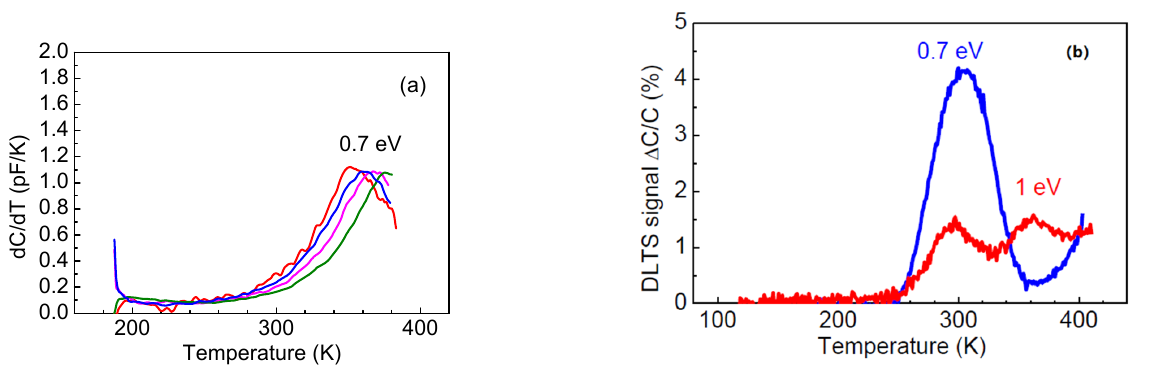
Figure 15. ( a ) Low ‐ frequency dC/dT after irradiation (measurements at frequencies of 20 Hz (red line), 30 Hz (blue line), 50 Hz (magenta line), 100 Hz (olive line)); ( b ) DLTS spectra before and after irradiation.